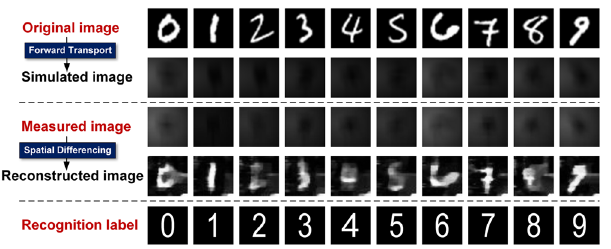
Fig. 2 Examples of the original images, measured images, and recognition labels in the proposed passive non-line-of-sight recognition system in a dark room. The simulated image is produced using the forward transport model (Supplementary Note 2.1), and the reconstructed image is produced using the spatial differencing reconstruction method (Supplementary Note 2.2) proposed by Saunders et al. 20